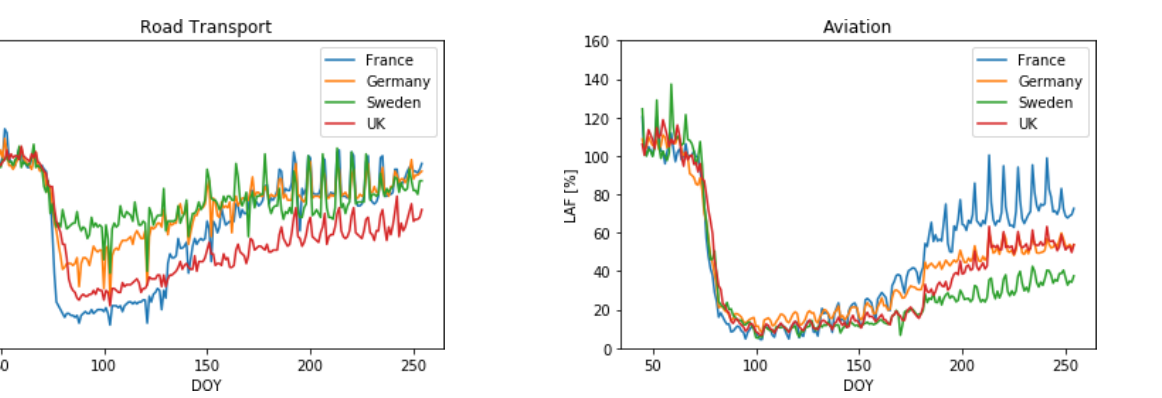
Figure A2. Daily values for lockdown adjustment factors (in %) for the sector H_Aviation based on Eurocontrol